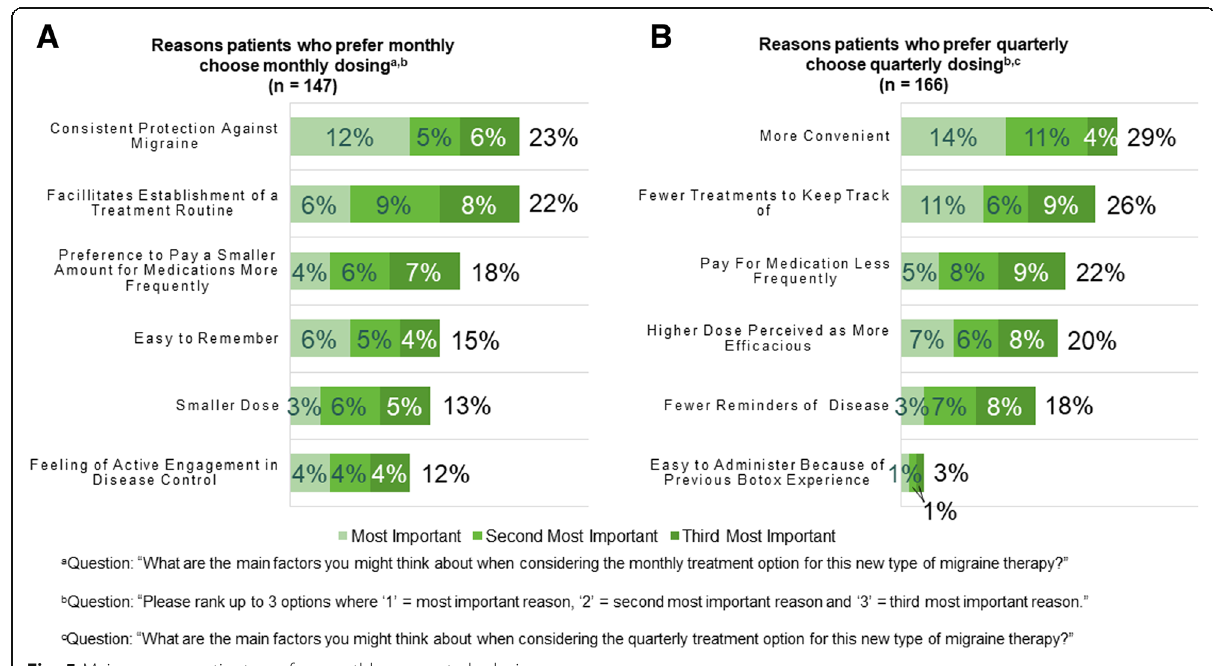
Fig. 5 Main reasons patients prefer monthly or quarterly dosing